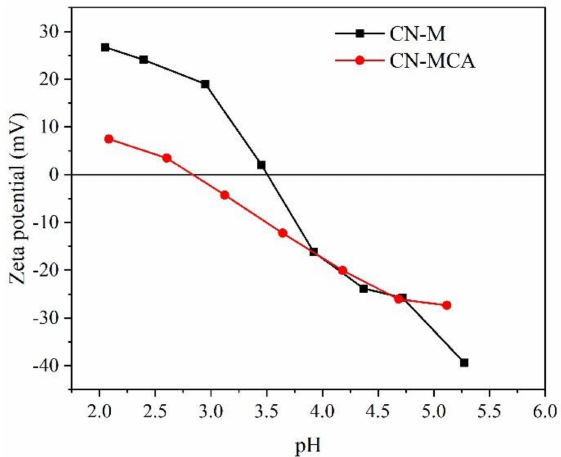
Figure 6. Zeta potentials of CN materials depending on